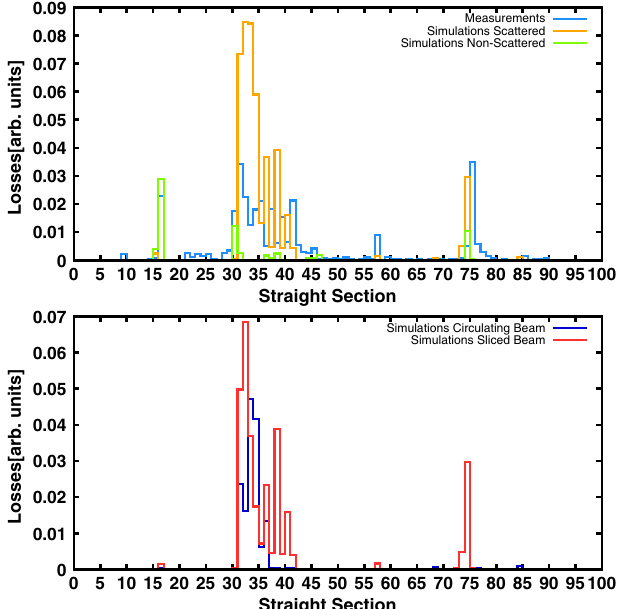
FIG. 19. Beam loss distribution for new CT optics scheme (color legend as in Fig. 15). Beam losses have been displaced from SS05-09 to the SS73 area.